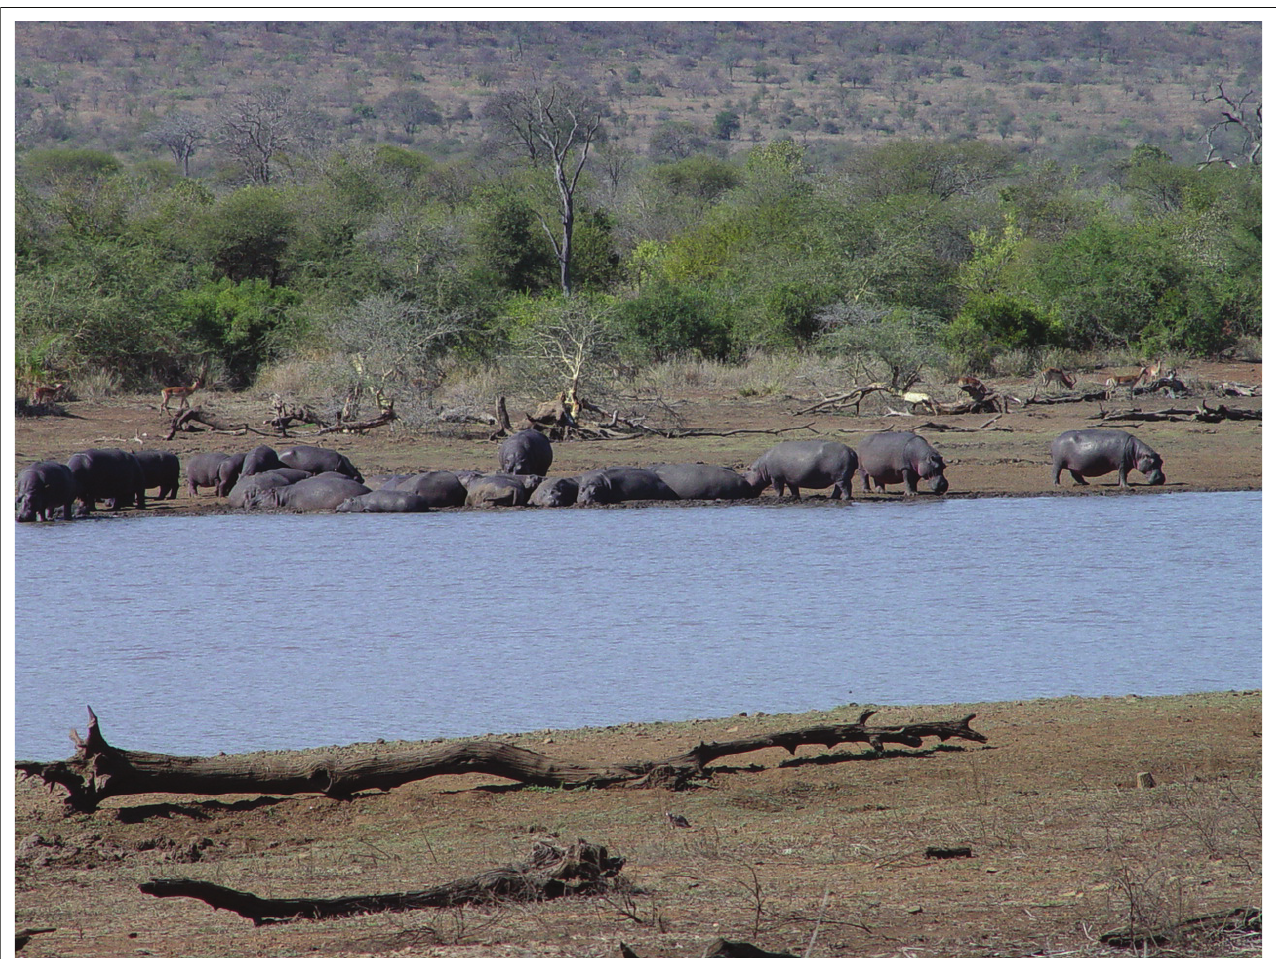
Source : Photo taken by R.G. Bengis FIGURE 2: High concentrations of hippopotami at Nhlanganzwane